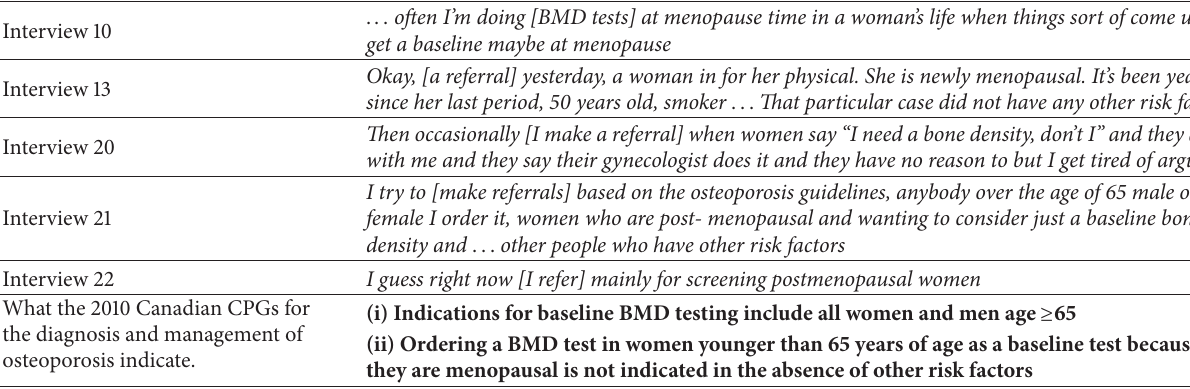
Table 1: Screening postmenopausal women in the absence of other clinical risk factors.